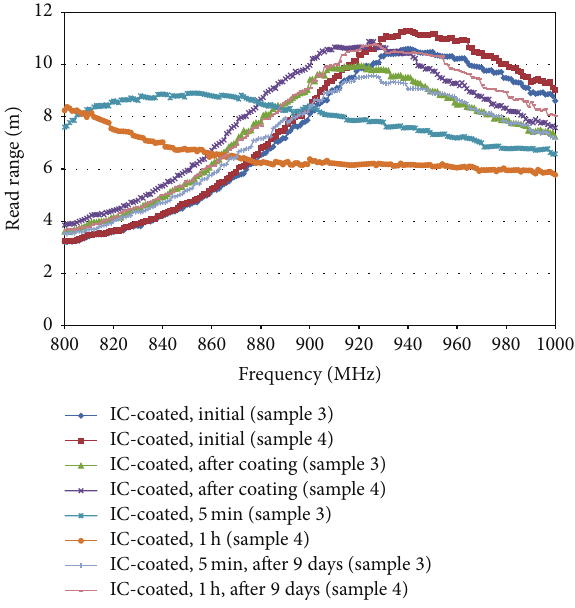
Figure 4: Measurement results for IC-coated sensor tags.